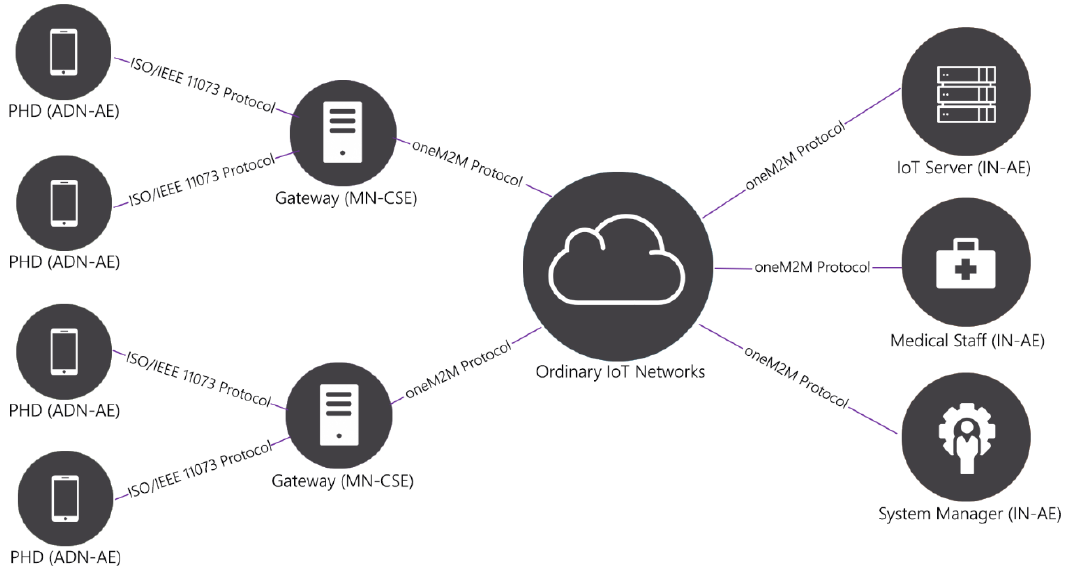
Figure 1. Structure of the IoT (Internet of Things) system for monitoring patients at home.